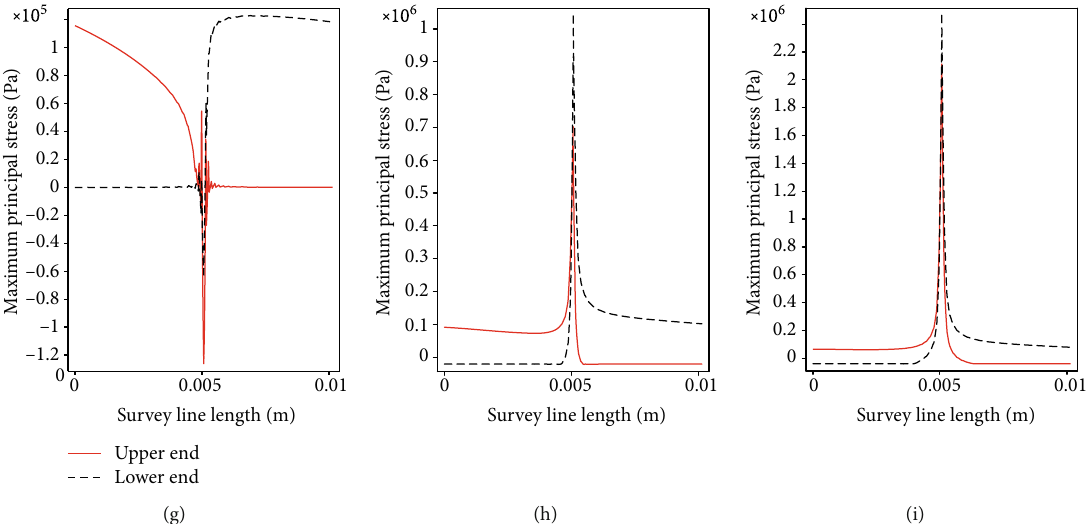
Figure 8: (a – c) Temperature and pore deformation characteristics of vacuum pores, saturated humid air pores, and liquid-containing pores. (d – f) Maximum principal stress distribution and stress direction characteristics. (g – i) Distribution of the maximum principal stress at the upper- and lower-tip contours.